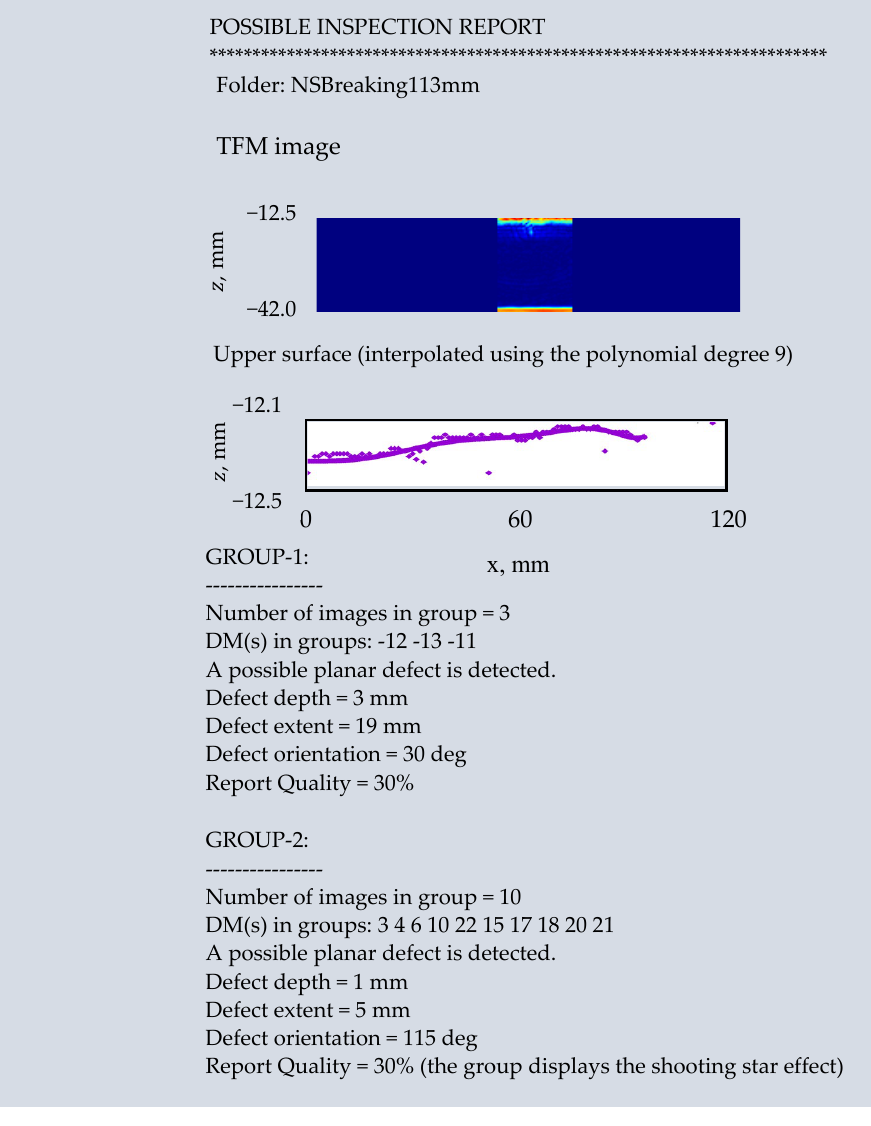
Figure 9. Inspection report for the surface-breaking notch located 113 mm from the left